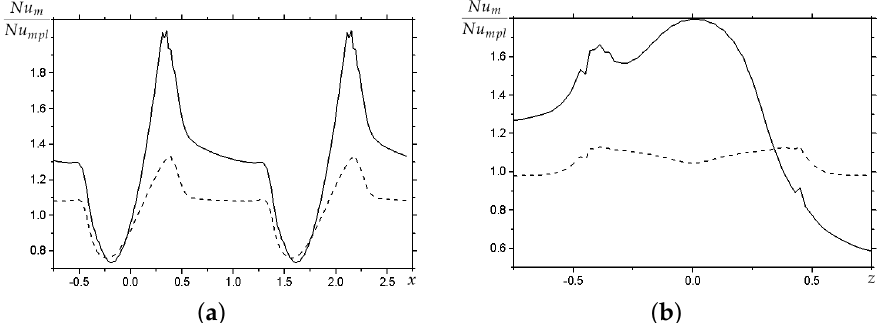
Figure 12. Comparison of band-averaged relative Nu ( x ) ( a ) and Nu ( z ) ( b ) with spherical dimples. The solid lines are ∆ = 0.2 and the dashed lines are